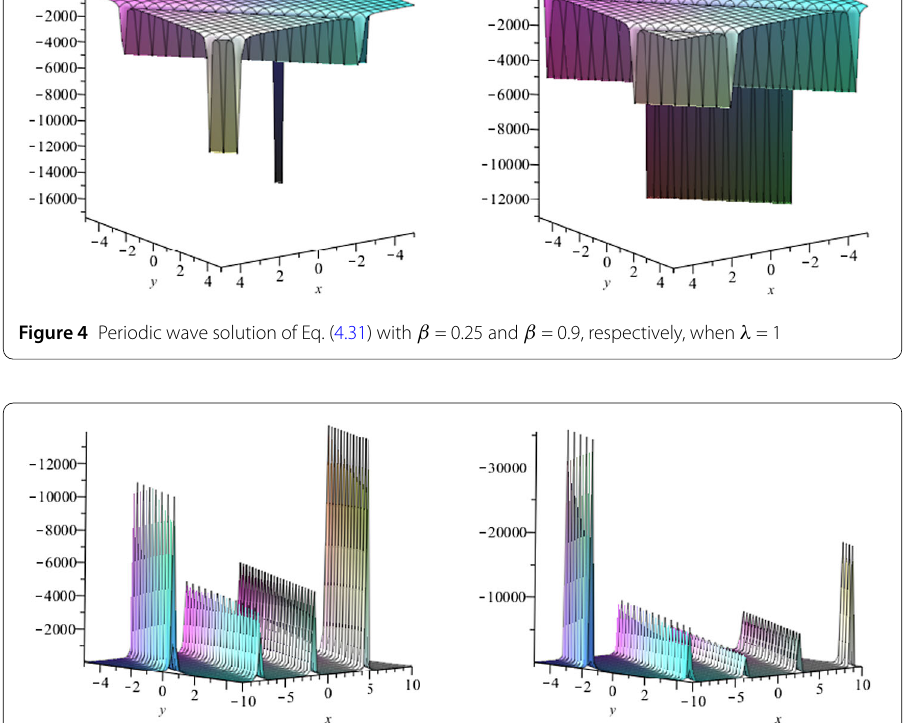
tions. Some diagrams have been given in three dimensions for fractional order to illustrate the behavior of the solutions when the parameters take some special